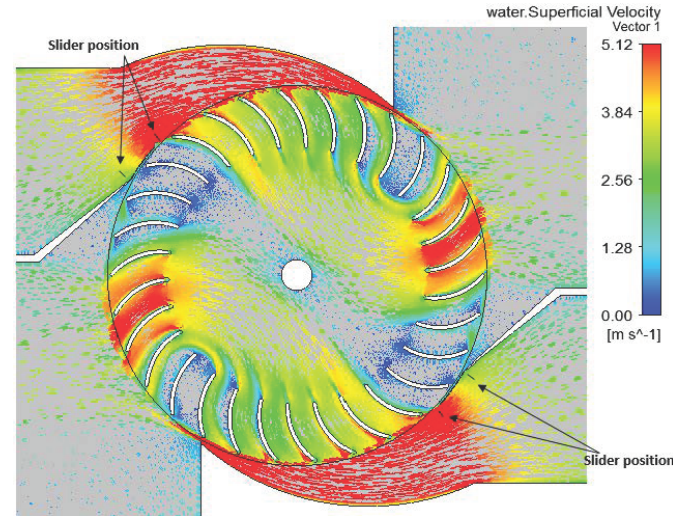
Figure 11. Mean water velocity vectors at part-flow operation at maximum efficiency [ Q = 40 lps, H = 1.337 m, ω = 199 RPM, and θ s = 78 ◦ ]. It is noted that only the inlet portion of the slider in the nozzle section has been modelled. The end of the slider, labeled the “slider position” for Q max and Q = 40 lps is shown for both